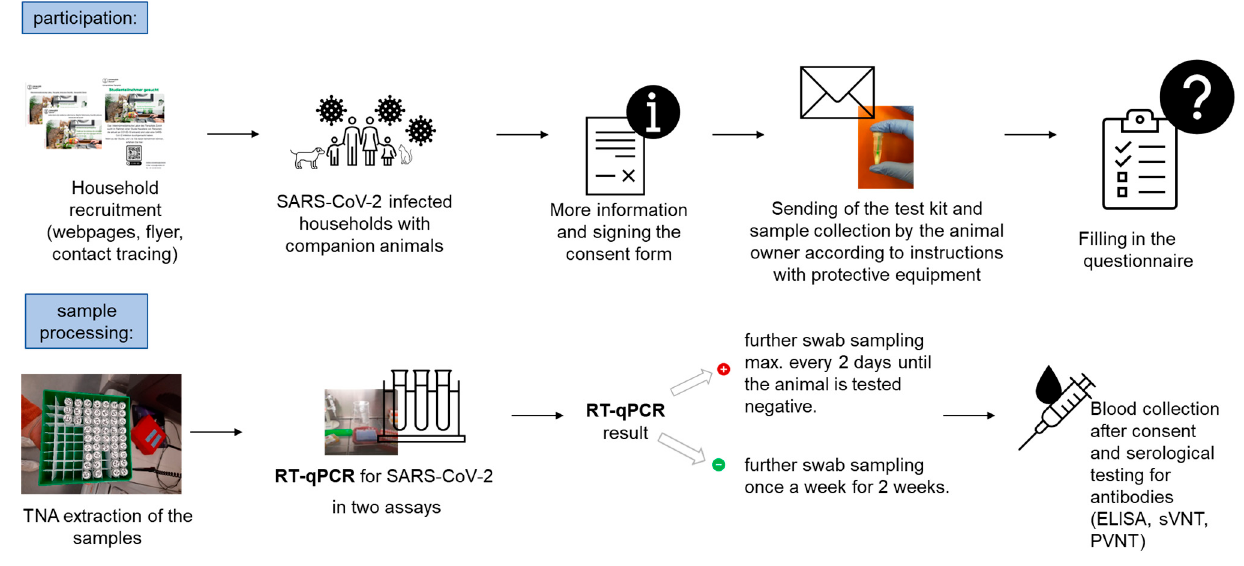
Figure 1. Study design for the recruitment process and sample analyses (TNA = total nucleic acid; ELISA = enzyme-linked immunosorbent assay; sVNT = surrogate virus neutralization test; and PVNT = pseudotype-based virus neutralization assay).